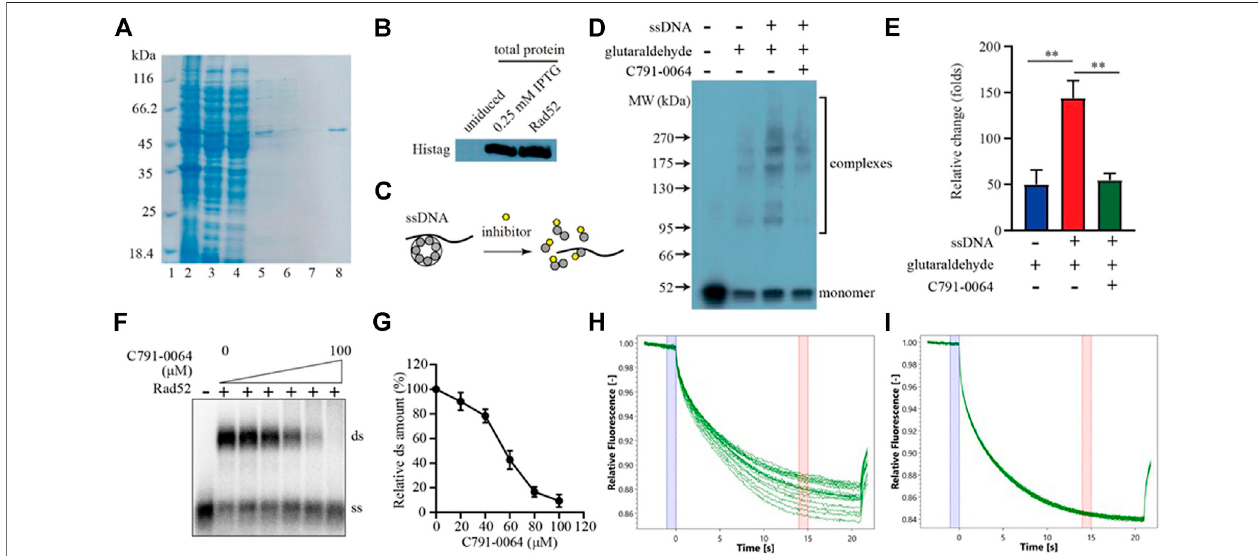
FIGURE 4 | C791-0064 inhibited RAD52 self-association. (A) Puri fi cation of human RAD52 protein analyzed by SDS-PAGE. Lane 2, total cell lysate; lane 3, supernatant; lane 4, Ni sepharose fl ow-through; lane 5, Ni sepharose eluate; lane 6, heparin fl ow-through; lane 7, heparin wash; and lane 8, heparin eluate. (B) Western blot analysis of RAD52 expressing plasmid-transformed E. coli cell lysate and puri fi ed RAD52 protein with anti-Histag antibody. (C) Schematic illustration of the electrophoretic mobility shift assay (EMSA). (D) Western blot of the EMSA result detected with anti-Histag antibody. (E) Quanti fi cation of the relative amount of polymer protein; the values were normalized by setting the value of no C791-0064, glutaraldehyde, and ssDNA reaction to be 100% ( n (cid:2) 3, error bars stands for SD). (F,G) Single-strandannealingef fi ciencyofRAD52inthepresenceofC791-0064. ds, double strand;ss,singlestrand. (H,I) Microscalethermophoresis (MST)analysisof C791-0064 (H) and G672-0031 (I) binding to Rad52